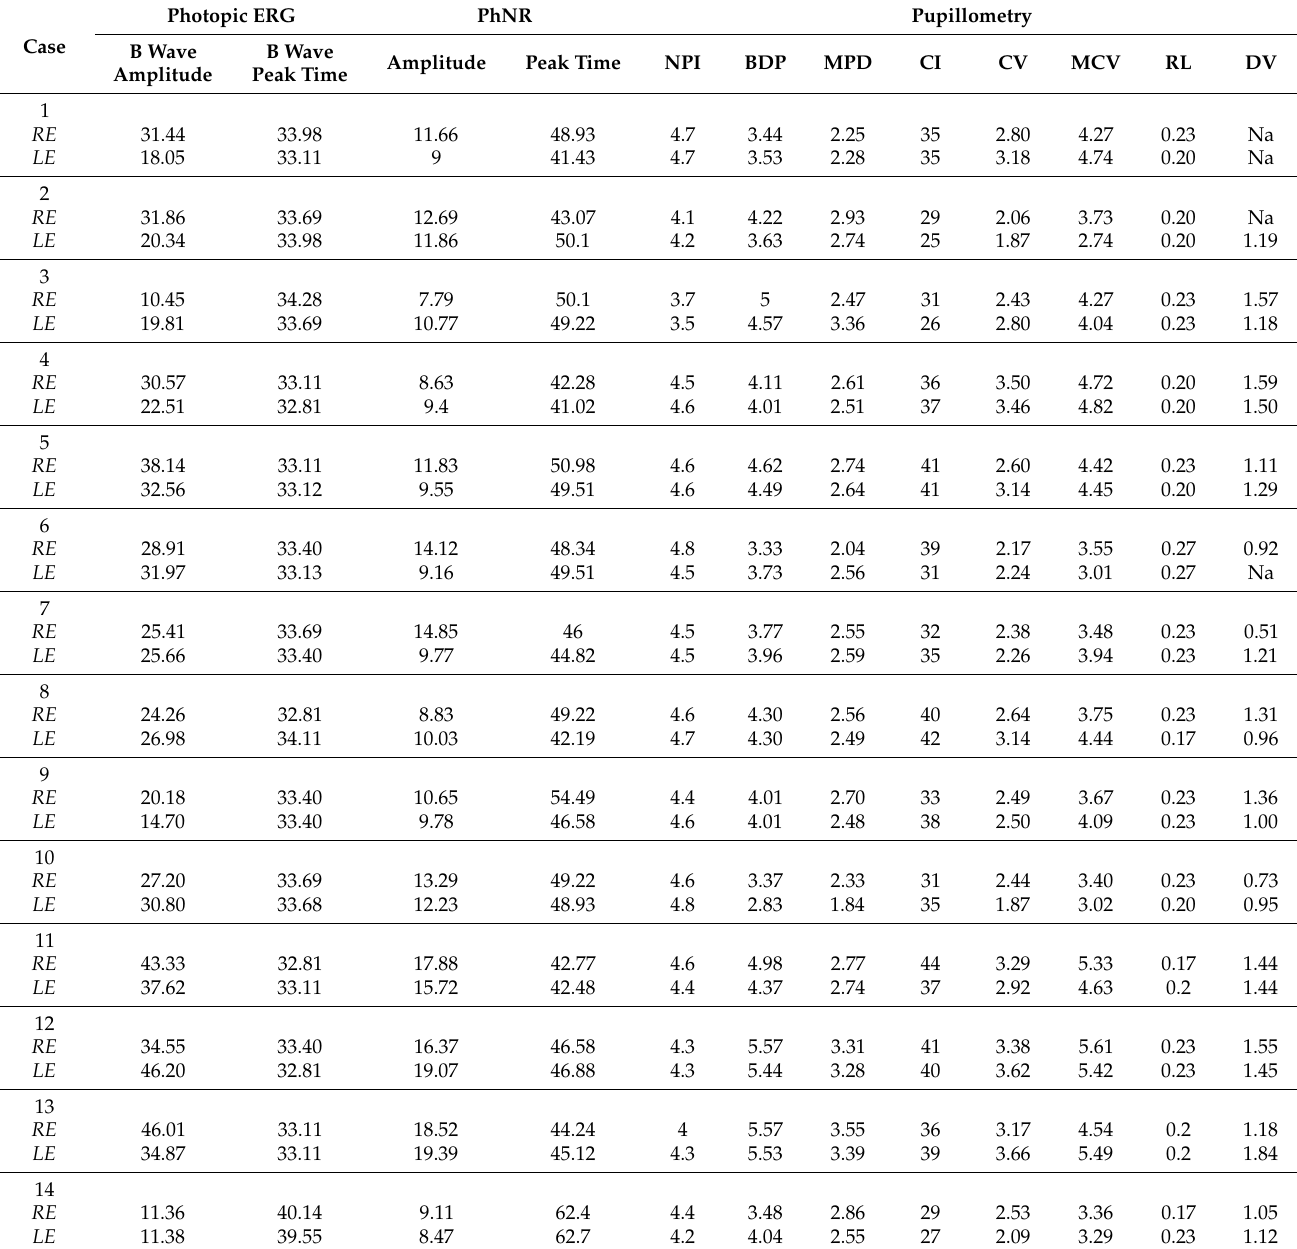
Table 2. Electrophysiological and pupillometric